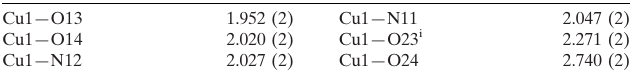
Selected bond lengths (A˚ ).